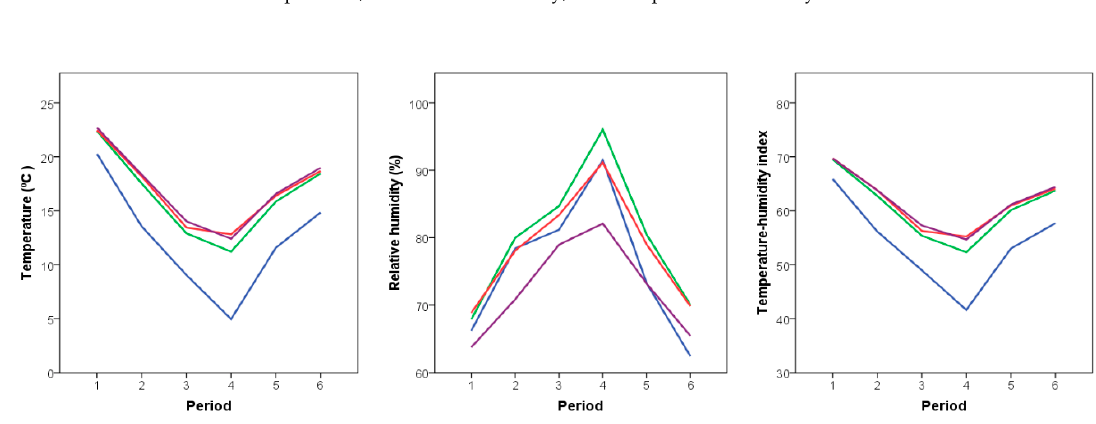
Table 4. Variation of the initial weight, average daily gain (ADG) and percentage of deaths as a function of the period of study.